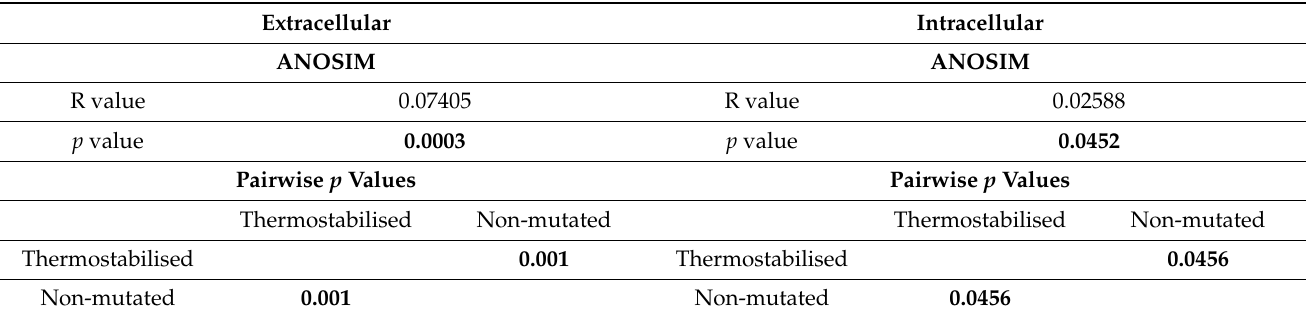
Figure 6. Principal component analysis to show the shape variation between non-mutated and thermostabilised receptors. Non-mutated are blue and thermostabilised are red. ( a ) PC score comparison for the extracellular face of the A2AR, β 1AR and β 2AR transmembrane bundles. ( b ) PC score comparison for the intracellular face of the A2AR, β 1AR and β 2AR transmembrane bundles. The supporting statistical data are summarised in Tables 8 and 9. Additional supporting figures are found in Appendix B Figure A4. Table 8. A summary of ANOSIM (clustering) test data for the extra- and intracellular faces of the A2AR, β 1AR and β 2AR receptors, to support Figure 6; 9999 permutations performed on PC1-5, significant p values (<0.05) are shown in